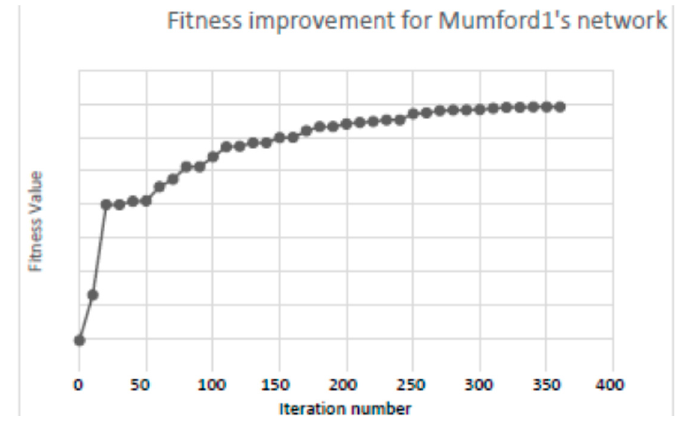
Figure 6. Fitness improvement for Mumford1 network (70 nodes).